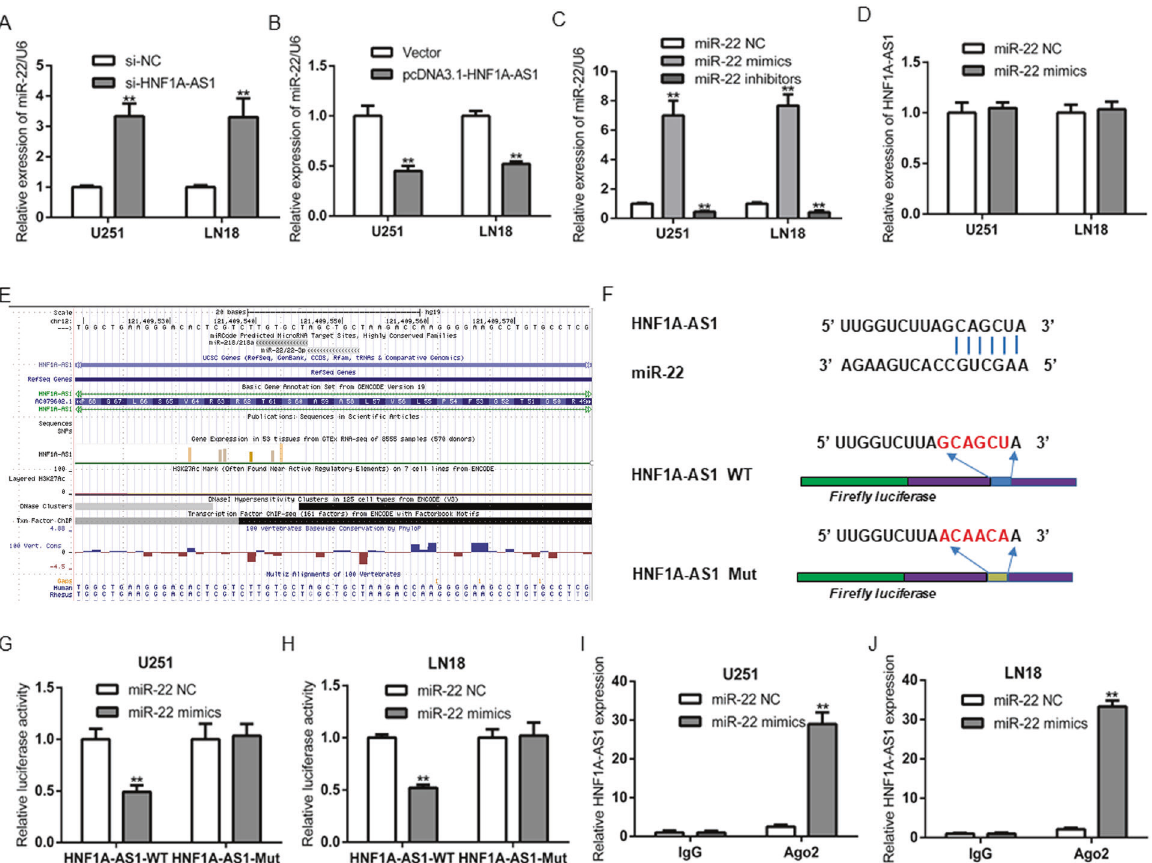
Fig. 4 HNF1A-AS1 expression was negatively associated with miR-22 expression in GBM. A , B Relative expression of miR-22 in U251 and LN18 cells transfected with si-HNF1A-AS1, si-NC, pcDNA3.1-HNF1A-AS1 and Vector. ** P < 0.01 vs. si-NC group. C The ef fi ciency of miR-22 expression levels after GBM cells transfected with miR-22 NC, miR-22 mimics and miR-22 inhibitors. ** P < 0.01 vs. miR-22 NC group. D Relative expression of HNF1A-AS1 in U251 and LN18 cells transfected with miR-22 mimics and miR-22 NC. E , F The conservation of HNF1A-AS1 in the binding site of miR-22 was snapshotted from human genome in UCSC Genome Browser and bioinformatics date predicted the putative binding sites of miR-22 on HNF1A-AS1. G , H Luciferase activity in U251 and LN18 glioma cells co-transfected with miR-22 mimics and luciferase reporters containing HNF1A-AS1-WT or HNF1A-AS1-MUT transcript. ** P < 0.01 vs. miR-22 NC group. I , J RNA-IP with anti-antibody was performed in U251 and LN18 cells transfected with miR-22 NC and miR-22 mimics. HNF1A-AS1 expression level was detected using RT-QPCR. ** P < 0.01 vs. miR-22 NC group. Data were presented as mean ± SD from three independent